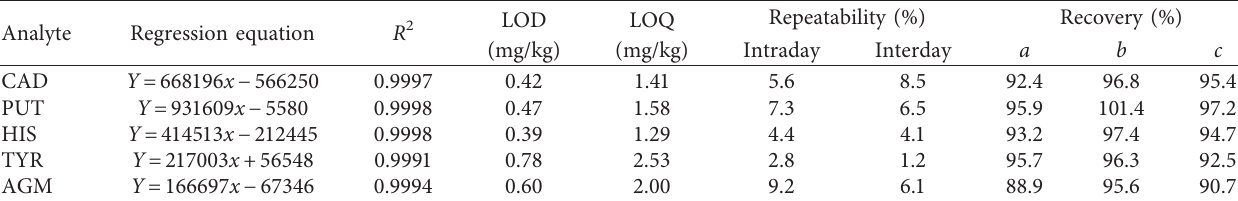
R 2 , square of regression coefficient; LOD, limit of detection; LOQ, limit of quantification; RSD, relative standard deviation; TYR, tyramine; PUT, putrescine; CAD, cadaverine; HIS, histamine; AGM, agmatine; a , 10mg/kg; b , 50mg/kg; c , 100mg/kg. Table 3: Performance of the ion-pair HPLC method for biogenic amine determination in canned mackerel.